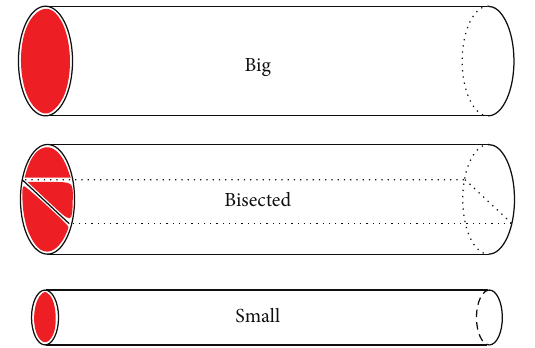
Figure 1: Geometries for comparison with Fick’s 2nd law and one- dimensional simulations (length: 1mm; big diameter: 4𝐸 − 3 mm; small diameter: 2𝐸 − 3 mm; red is the inlet area).